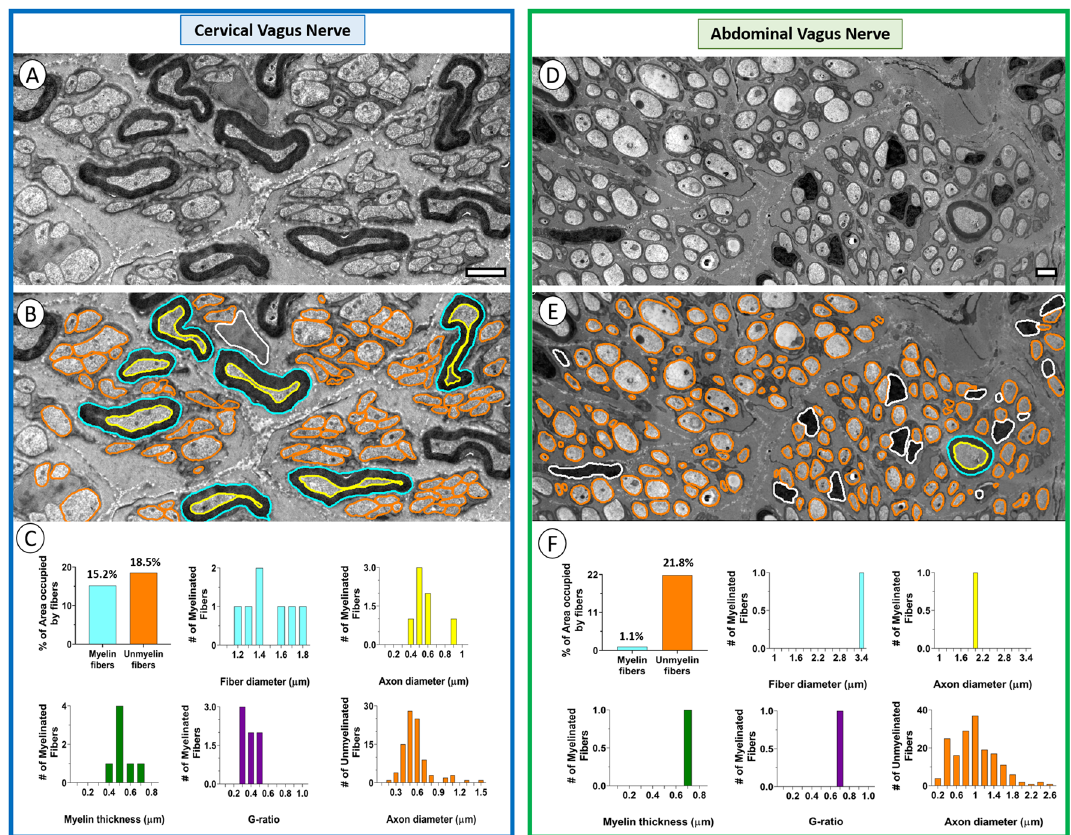
Figure 4. Data segmentation of myelinated and unmyelinated fibers of cervical and posterior abdominal segments of the human vagus nerve. ( A ) Electron micrograph of a representative area of the left cervical vagus nerve in a 49 year old male subject. Note small group of myelinated fibers surrounded by numerous unmyelinated axons and single Schwann cell nucleus. Scale bar = 2 µm. ( B ) The outer and inner circumferences of each myelin sheath was contoured individually and indicated in blue and yellow, respectively. All unmyelinated fiber outlines were contoured in orange. ( C ) Quantitative analysis derived from segmented data, including percent area occupied by myelinated and unmyelinated fibers, size distributions for fiber and axon proper diameters of myelinated fibers, myelin thickness, G-ratios for myelinated axons, and axon diameters for unmyelinated axons. ( D ) Electron micrograph of a representative area from the posterior abdominal branch of the vagus nerve in a 52 year old male subject. Note single myelinated fibers surrounded by numerous unmyelinated axons and Schwann cell nuclei. Scale bar = 2 µm. ( E ) The outer and inner circumferences of the single myelinated fiber were contoured and indicated in blue and yellow, respectively. All unmyelinated fiber outlines were contoured in orange. ( F ) Quantitative analysis derived from segmented data, including percent area occupied by myelinated and unmyelinated fibers, size distributions for fiber and axon proper diameters of myelinated fiber, myelin thickness, G-ratio for myelinated axon, and axon diameters for unmyelinated